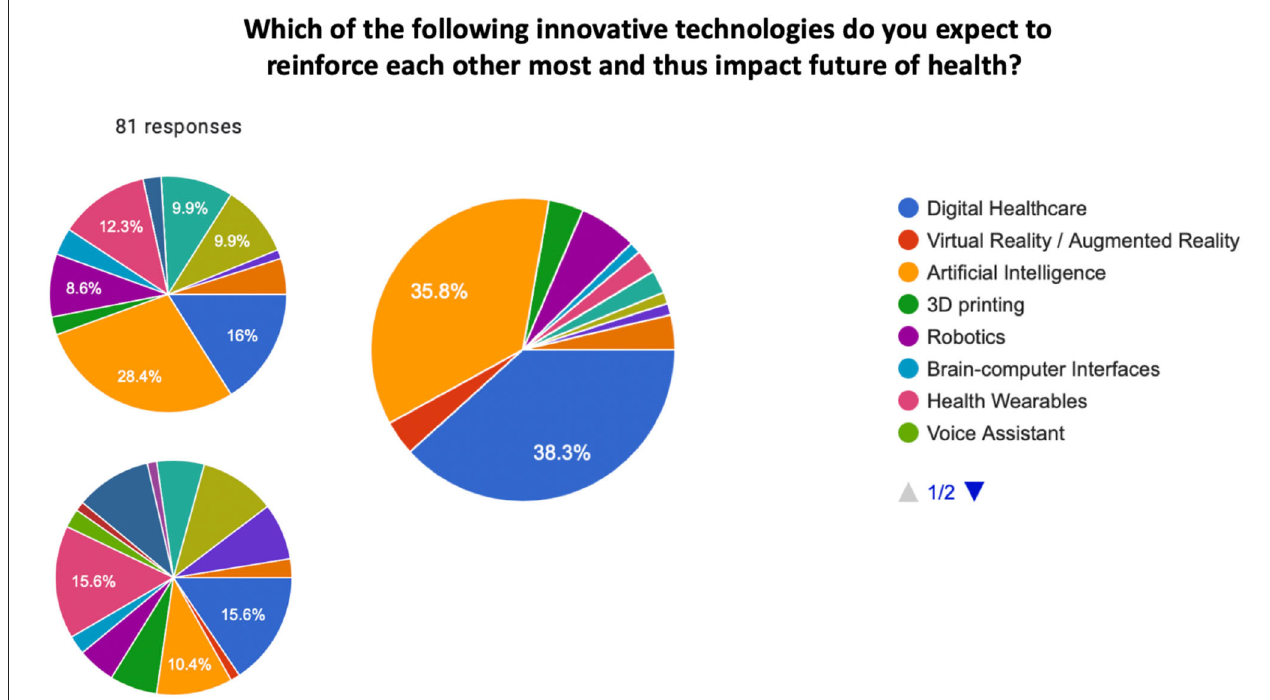
FIGURE 3 | Pie chart. Which of the following innovative technologies do you expect to reinforce each other most and thus impact the future of health? Options were: digital Healthcare, virtual reality / augmented reality, artificial intelligence, 3D printing, robotics, Brain-Computer Interfaces, health wearables, voice assistant, new touch interfaces, minimal invasive therapy systems, environmental protection and sustainability, data management, electronic and sensors, cybersecurity and data privacy, gene editing (CRISPR/Cas9). The most selected technologies to mutually reinforce each other were artificial intelligence, digital healthcare, and health wearables.